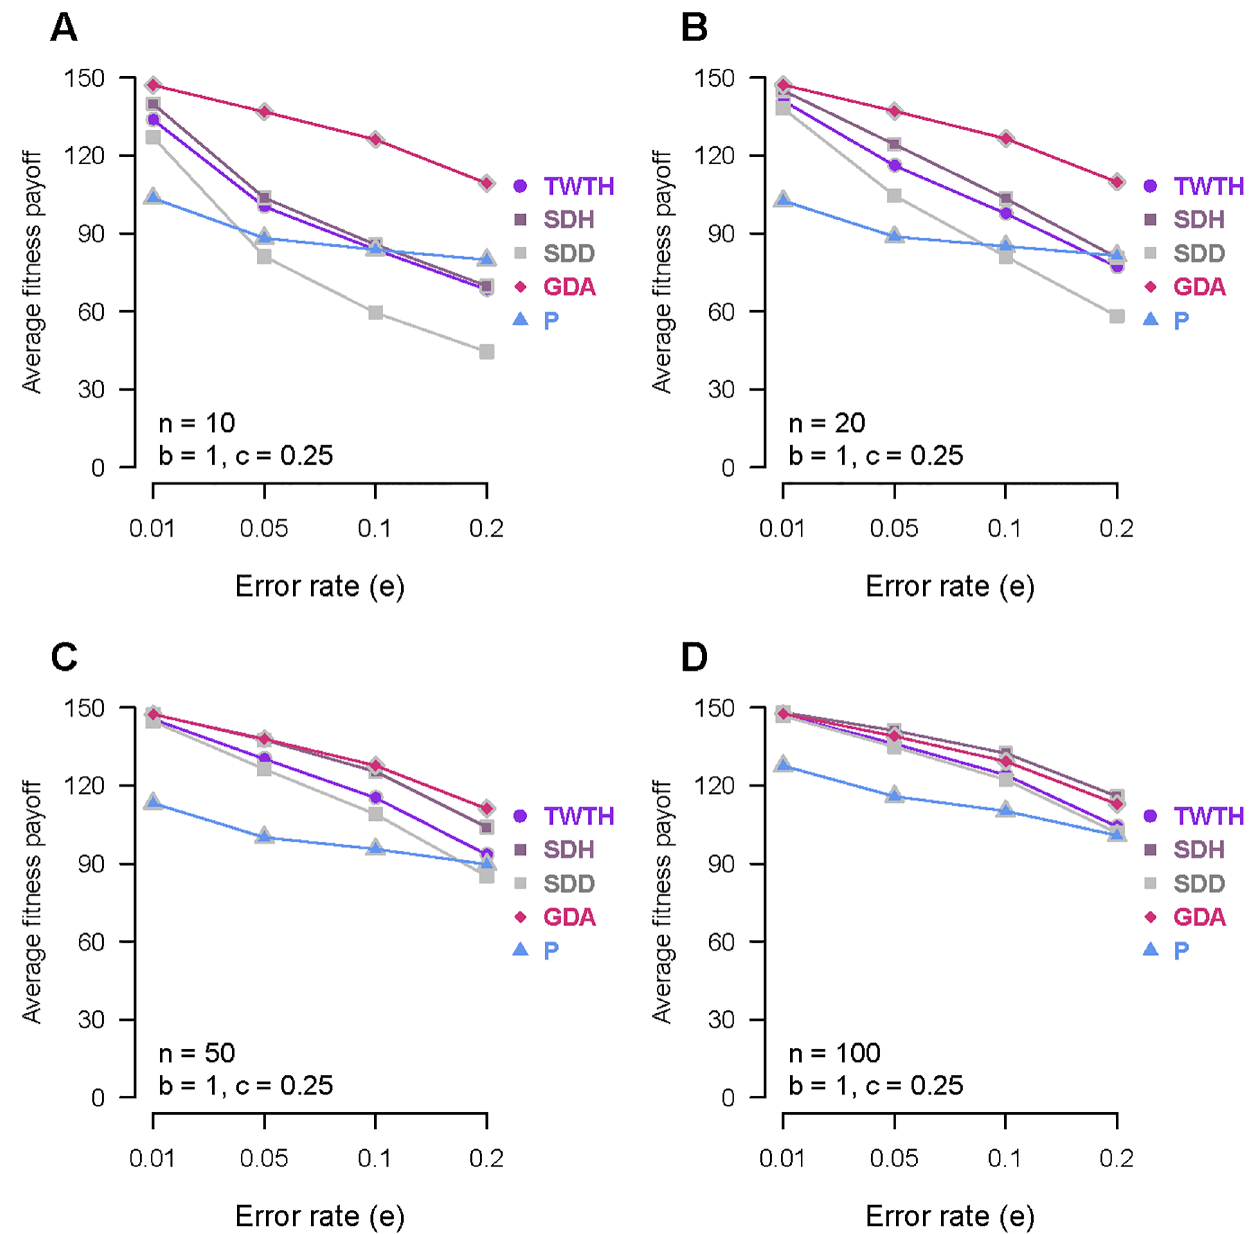
Fig 3. The average fitness payoff for five homogeneous groups which adopt the error-prone strategies at four different error rates. TWTH stands for TFT-with-trembling-hand. SDH stands for shame-driven-hiding. SDD stands for shame-driven-denying. GDA stands for guilt-driven-amending. P stands for Pavlov. (A) When b = 1, c = 0.25 and n = 10. (B) When b = 1, c = 0.25 and n = 20. (C) When b = 1, c = 0.25 and n = 50. (D) When b = 1, c = 0.25 and n =